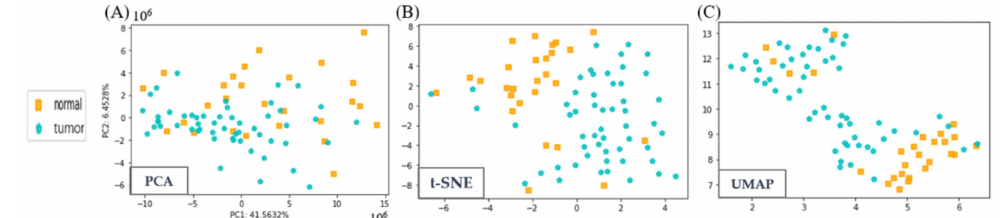
Figure 5. Visualization of the LCC dataset by PCA, t-SNE and UMAP. Each shape represents a sample. ( A ) The PCA plot is based on features extracted by KPIC2 of the LCC dataset, and the percentage of variance explained by each selected component is displayed on the axis; ( B ) the t-SNE plot is based on features extracted by KPIC2 of the LCC dataset; ( C ) the UMAP plot is based on features extracted by KPIC2 of the LCC